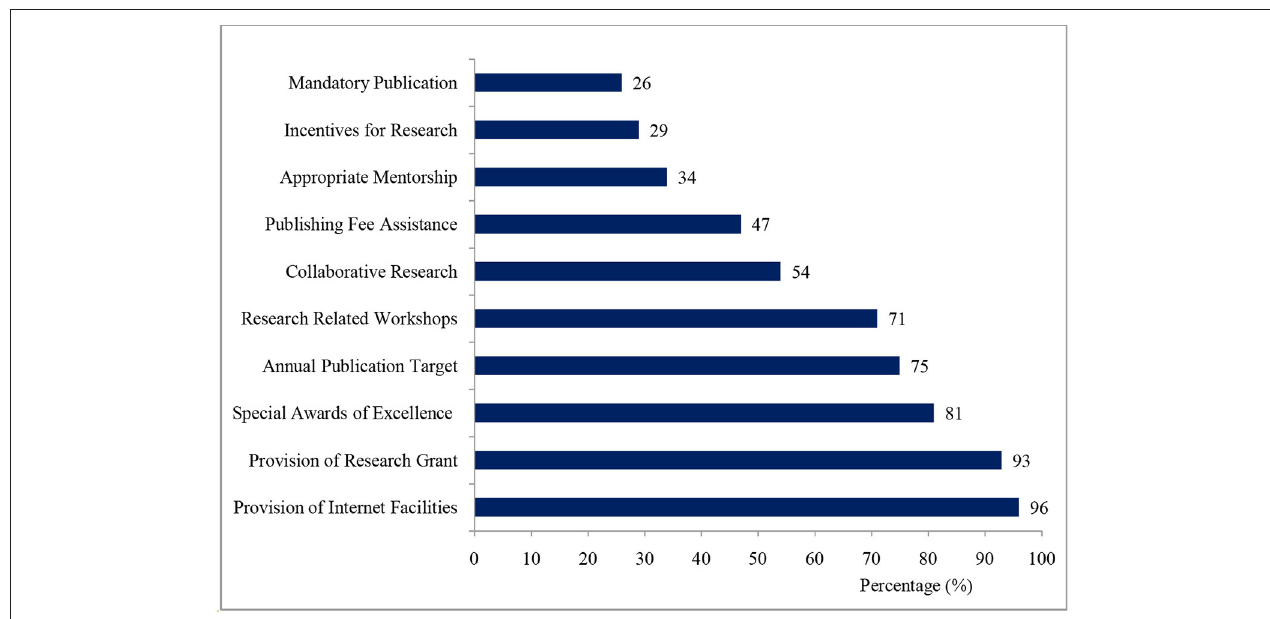
FIGURE 5 | Suggestions by participants for improving the status of research and